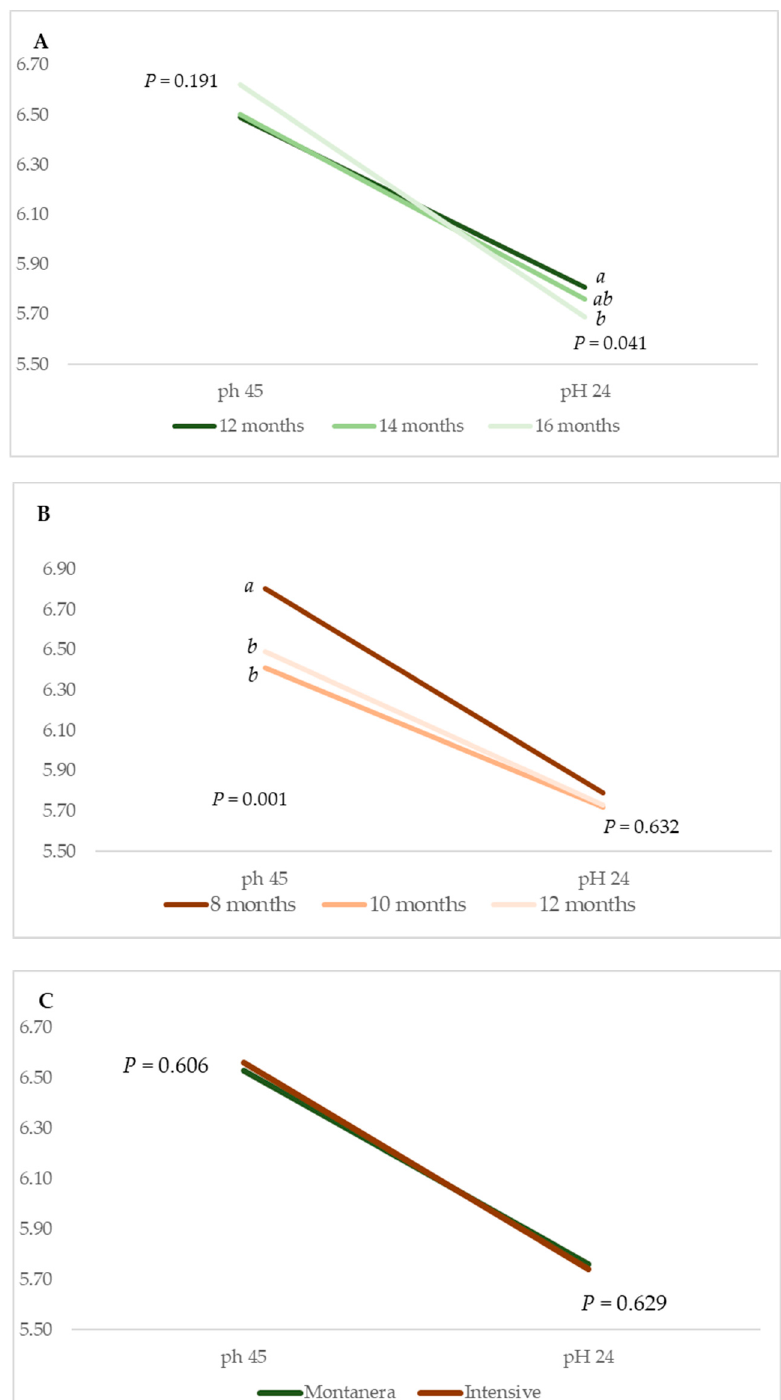
Figure 2. Arithmetic mean pH values measured in m . longissimus thoracis from Iberian × Duroc crossed animals at 45 min and 24 h after slaughter according to the age at slaughter of the animals in each production system: Montanera at 12, 14 and 16 months ( A ) and intensive at 8, 10 and 12 months ( B ) and the production system itself ( Montanera vs. Intensive) ( C ). Different letters indicate differences due to animal slaughter age within each production system for p = 0.05, according to Tukey´s HSD test.